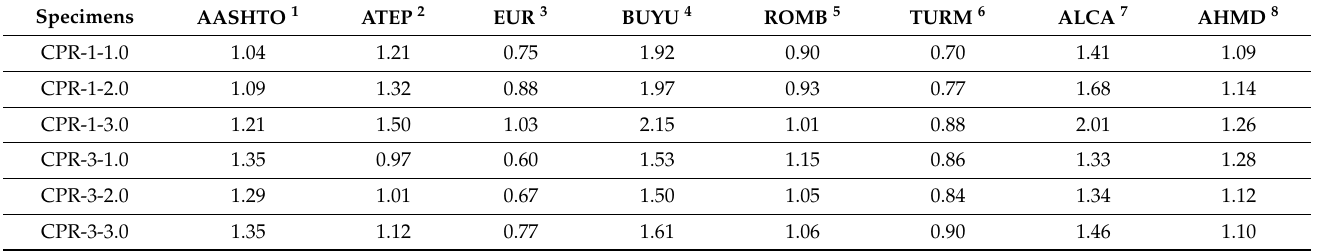
Table 11. Relationship between maximum normalized shear stress predicted by the literature equa- tions and experimental results.